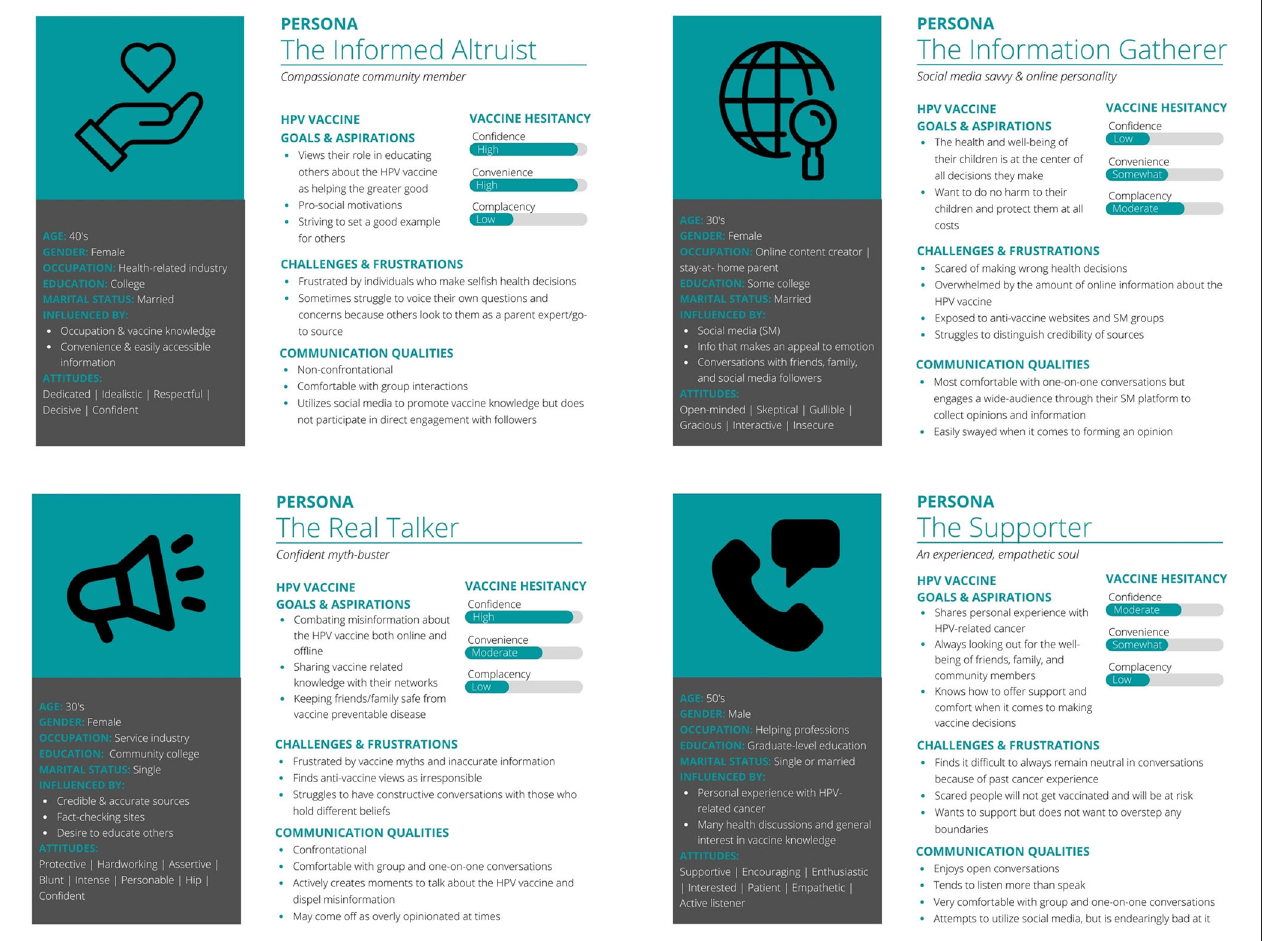
FIGURE 2 | Persona profiles of the informed altruist, the real talker, the information gatherer, the